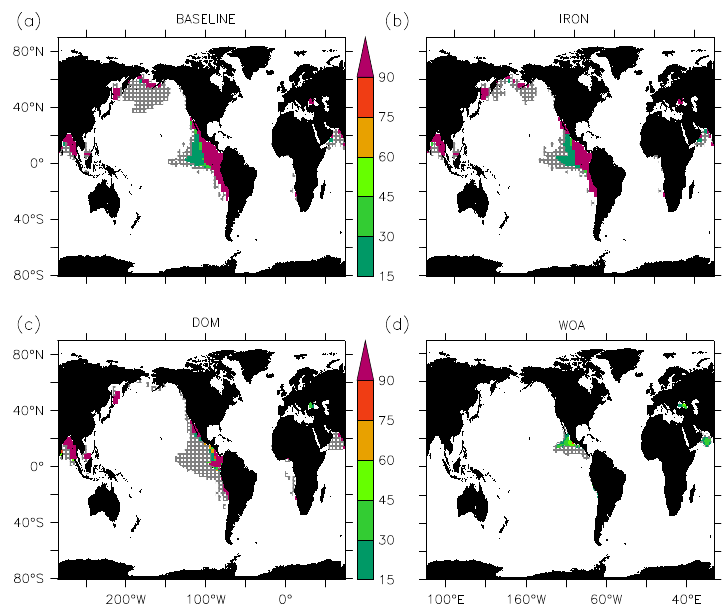
Fig. 7. Percentage of organic matter export remineralized in low oxygen waters ([O 2 ] <5mmolm − 3 ) for the (a) BASELINE, (b) IRON and (c) DOM simulations. Panels (a), (b) and (c) show averages over 150 model years. Panel (d) shows an estimate of this fraction derived for the real ocean combining the observed oxygen distribution (corrected WOA annual means, (Bianchi et al., 2012)) and a vertical profile of oxygen utilization based on the Martin curve (Martin et al., 1987) of particle flux attenuation. The onset of a vicious cycle can occur in regions where > 15% of the export is remineralized in suboxic waters (corresponding to coloured regions). Regions where less than 15% of the export is remineralized in OMZ correspond to the hatched grey areas .